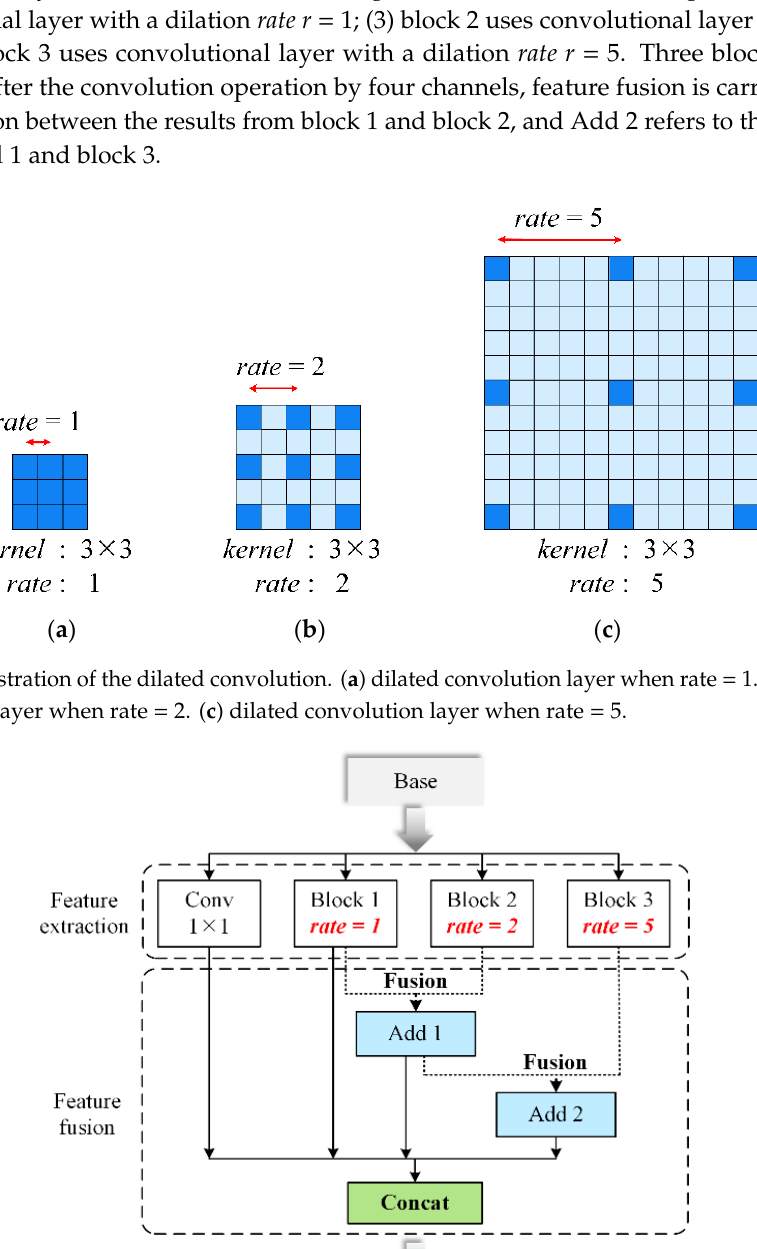
Figure 2. Illustration of the dilated convolution. ( a ) dilated convolution layer when rate = 1. ( b ) dilated convolution layer when rate = 2. ( c ) dilated convolution layer when rate = 5.